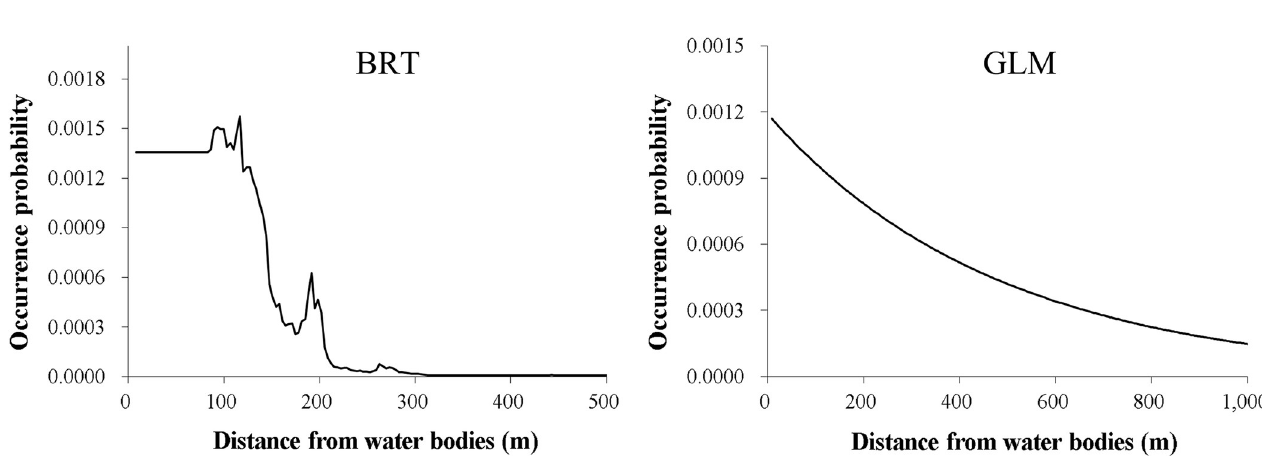
Fig 6. Response curves for the fourth important predictor, distance from water bodies for two of the five species distribution models for nutrias (producing Δ AUC values � 0. 05). BRT = Boosted Regression Trees; GLM = Generalized Linear Model.